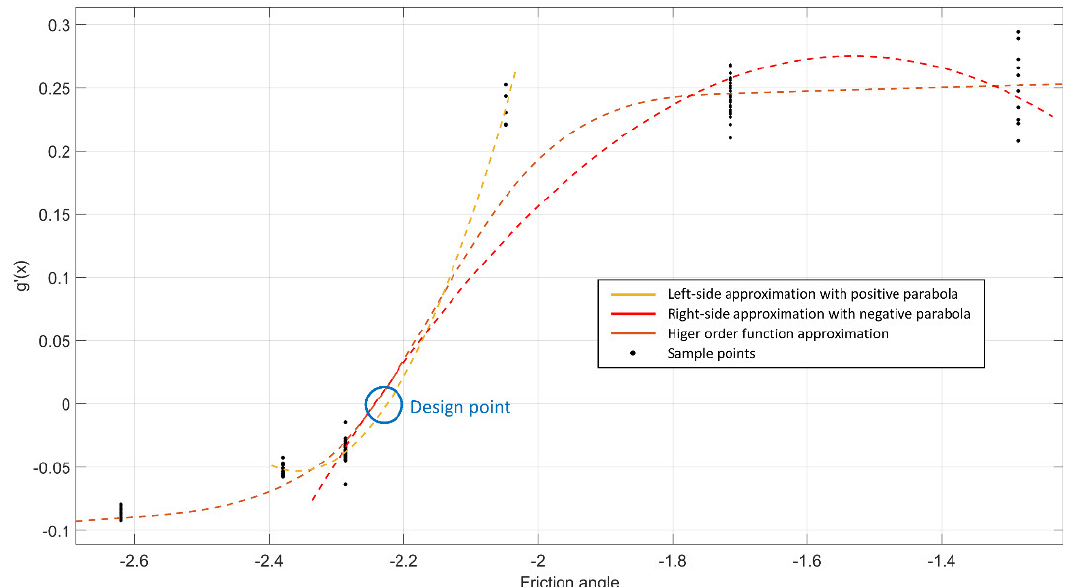
Figure 13. Situation where a cubic equation would be more appropriate (on the horizontal axis an interval of 0.1 = 0.35°).